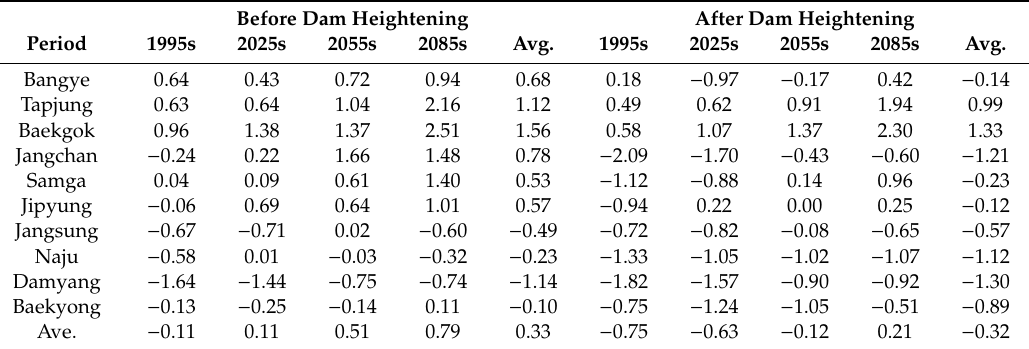
Table 6. Flood vulnerability indices before and after dam heightening by periods. Before Dam Heightening After Dam